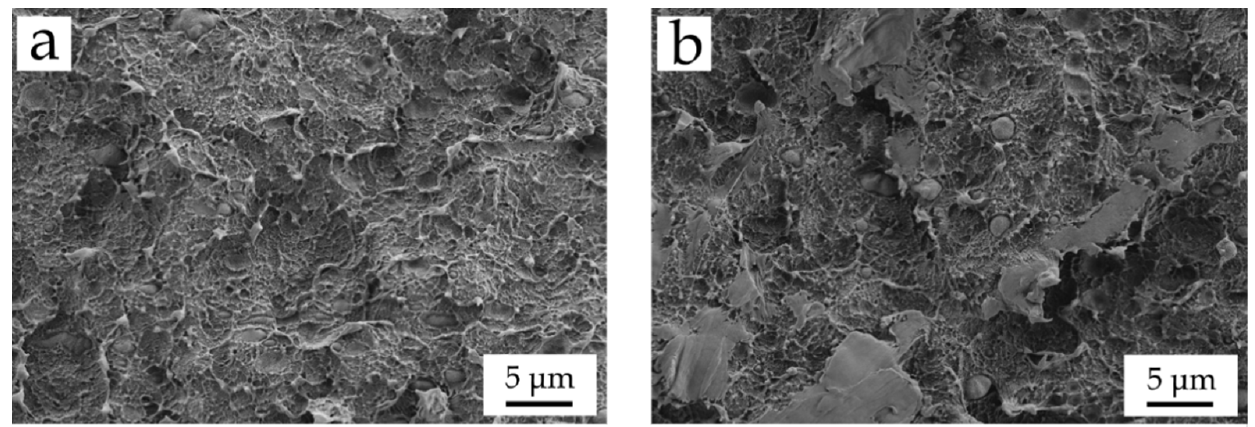
Figure 3. Field emission scanning electron microscopy (FESEM) images at 2000 × of the fracture surfaces of ( a ) neat BioHDPE, and ( b ) BioHDPE/PE-g-MA blend.